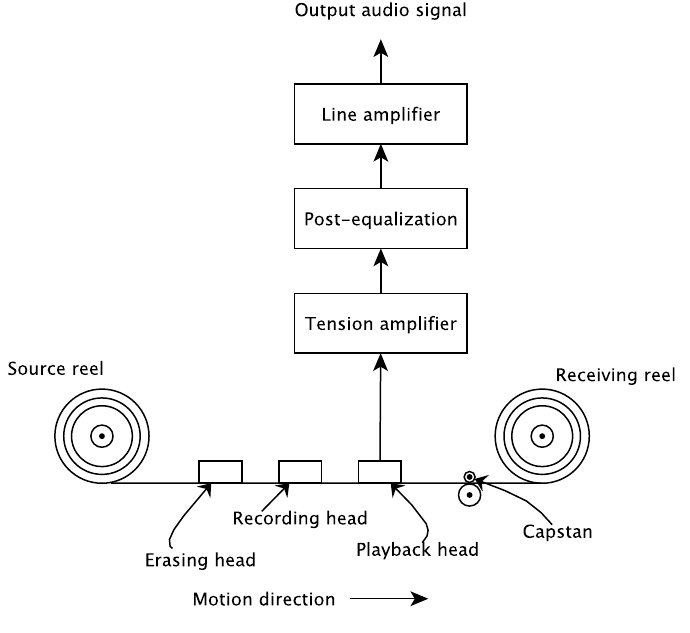
Figure 4. Scheme of a reel-to-reel tape recorder during the playback phase (adapted from [26]). To read the recorded magnetic signal, the tape is passed in front of the playback head on which the tape induces a variable magnetic field proportional to the recorded signal. This determines the generation of an induced electromotive force at the ends